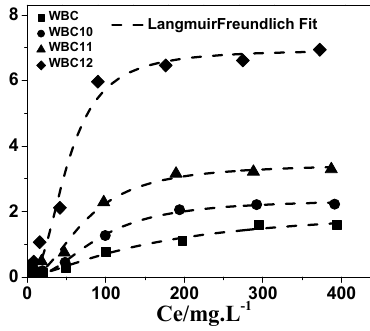
Figure 11. Adsorption isotherms of phosphate onto WBC and WBC1x.